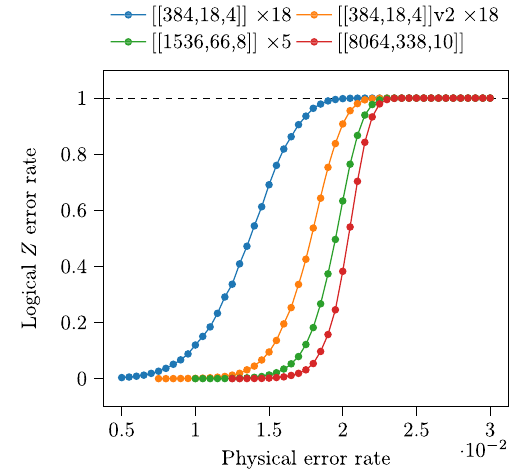
FIG. 20. Performance of the extremal subsystem f 8 ; 4 g l ¼ 2 semihyperbolic codes under a circuit-level independent noise model and using an X schedule.